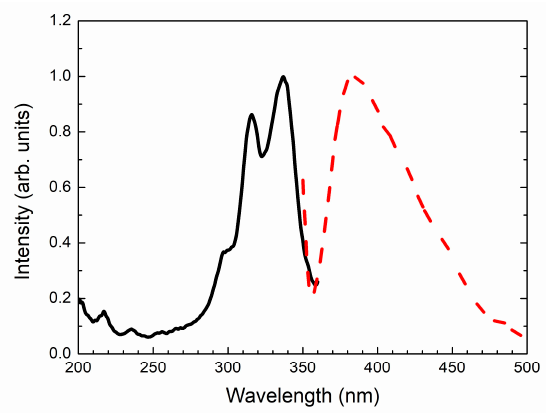
Figure 13. Photoluminescence (red dashed curve) of the fedorite sample Gav-43 under 337 nm excitation and excitation (black solid curve) spectra monitored at 390 nm measured at 77 K.